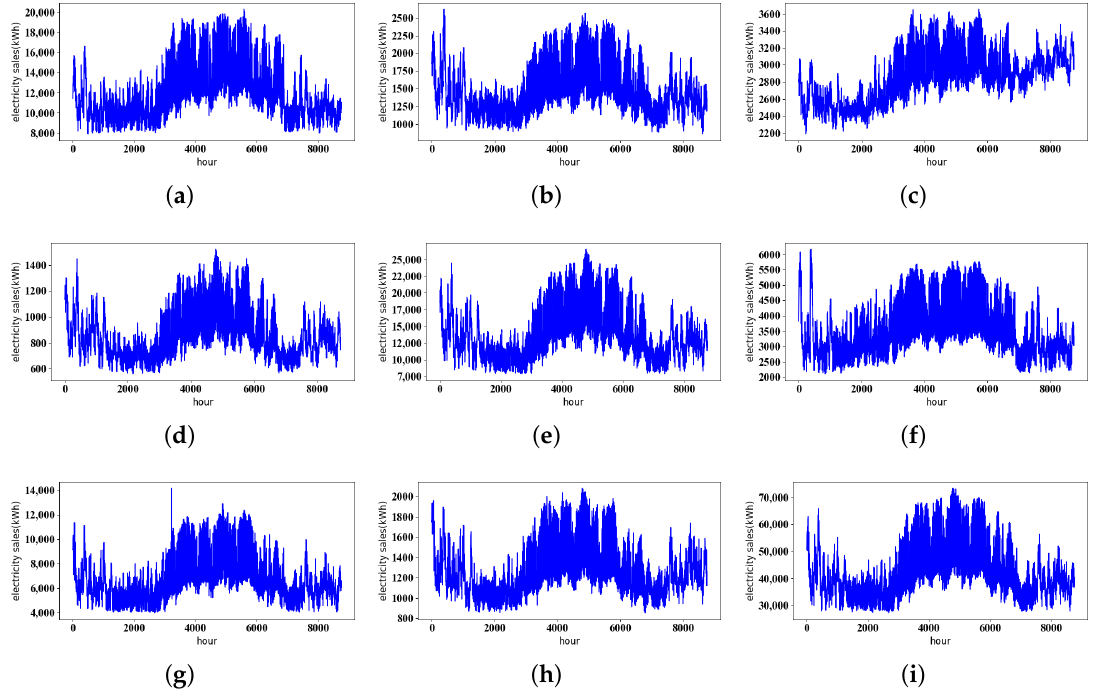
Figure 3. Electricity sales data for nine regions in Texas: ( a – i ) correspond to the nine regions in